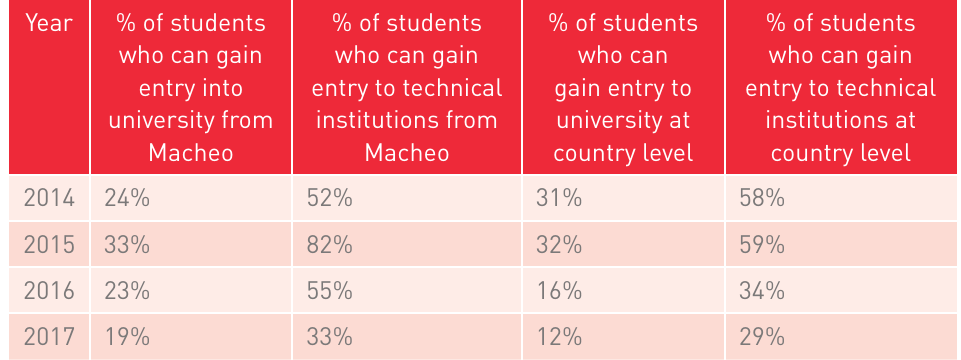
A Z-test comparison of performance for the period 2014–2017 Year Z-test for percentage mean difference between Macheo performance and country performance for students who can gain entry into university (p value)